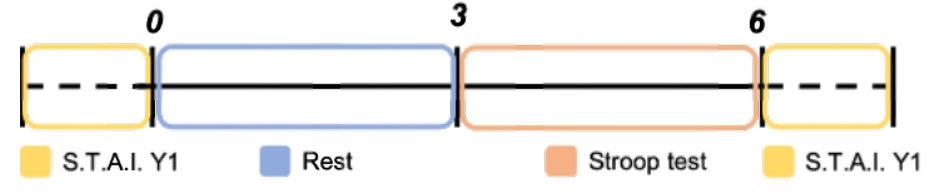
Figure 4. The experimental